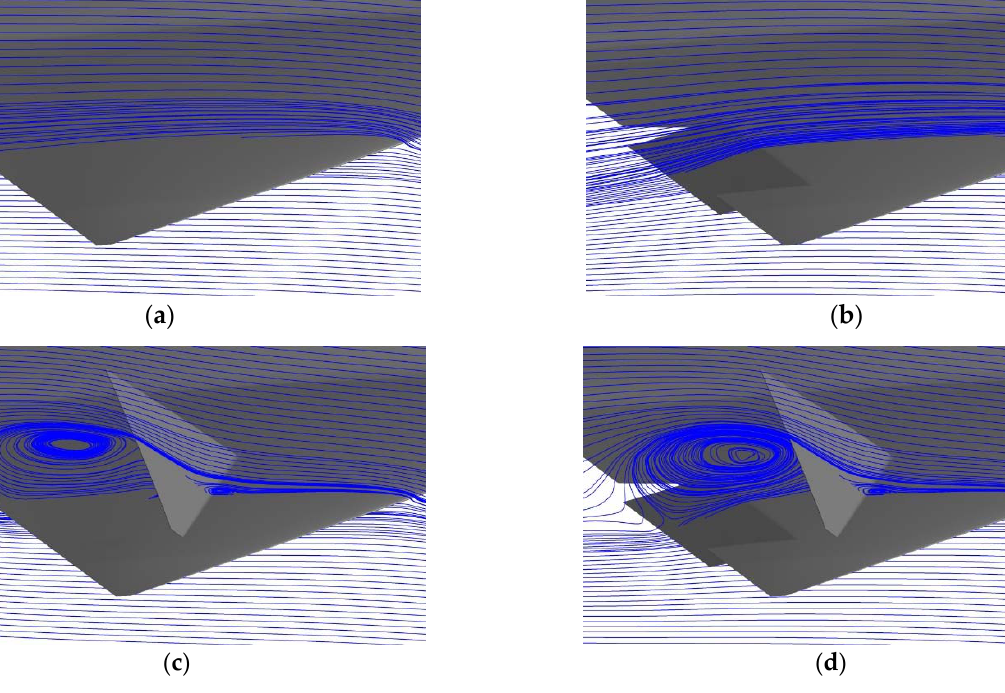
Figure 14. Spatial streamlines around the SSD3 and the corresponding FCR, Ma = 0.2, Re = 3.98 × 10 7 , α = 6°: ( a ) SSD3; ( b ) The corresponding FCR. When the SSD unfolds upward by 45° alone, the windward area increases. The SSD resists the flow near the fore of the wing on the upper surface, the flow velocity decreases, the pressure increases, and the negative pressure value decreases. The closer it is to the SSD, the larger is the variation of the negative pressure on the upper surface, forming a large differential pressure drag, and the airflow fills from the edge of the SSD to its lee ‐ ward area to form a separation vortex. Owing to the influence of the separation vortex, the airflow on the lower surface of the wing washes up and accelerates, reducing the pres ‐ sure on the entire lower wing surface. The closer it is to the trailing edge, the more is the pressure reduction, and these flow phenomena show that when the SSD unfolds, the pres ‐ sure distribution changes complexly, resulting in a change in drag and lift; hence, the